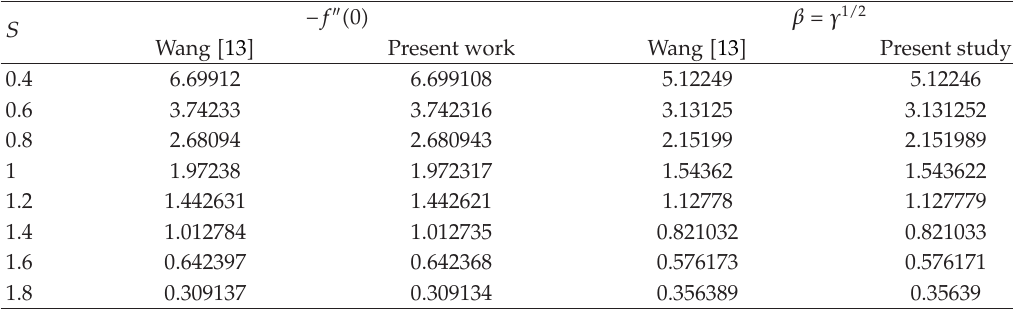
Table 1: Comparison of values of skin friction coe ffi cient − f (cid:5)(cid:5) (cid:3) 0 (cid:4) and β (cid:7) γ 1 / 2 using HPM.